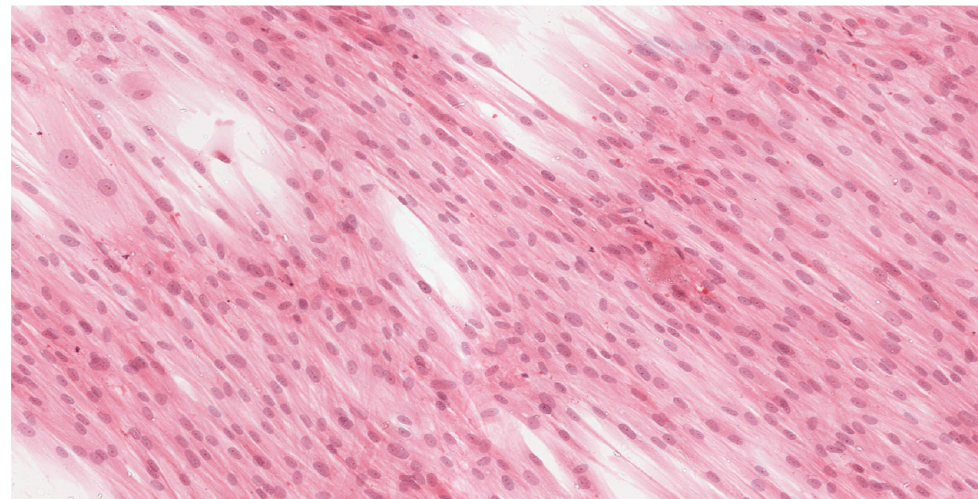
Figure 1. Image of control culture (K); 100× magnification.